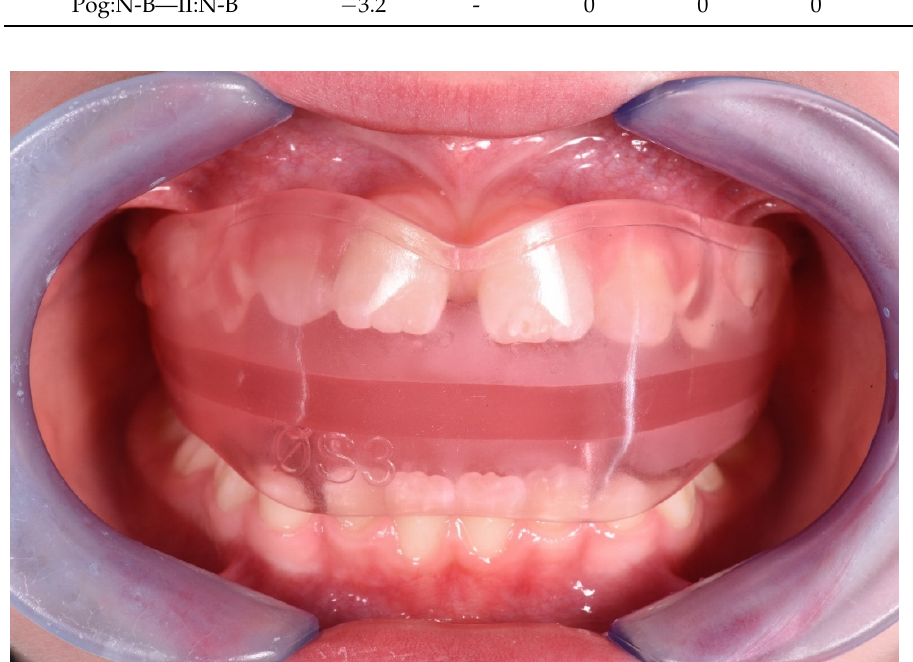
Figure 25. Intraoral photograph of the patient wearing the AMCOP OS.